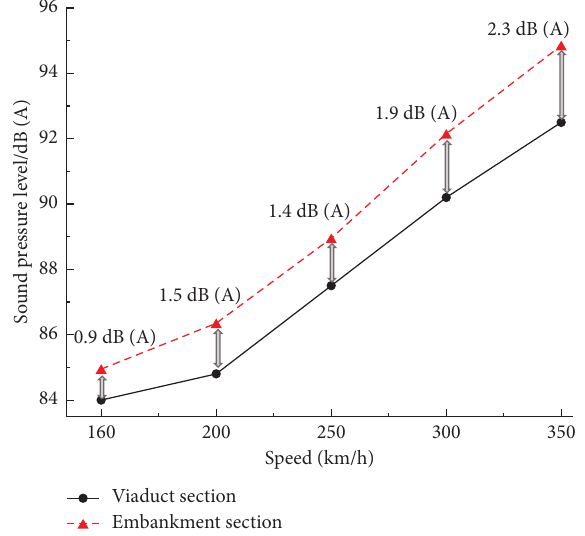
Figure 12: Sound pressure level at P3 at different speeds in the viaduct and embankment